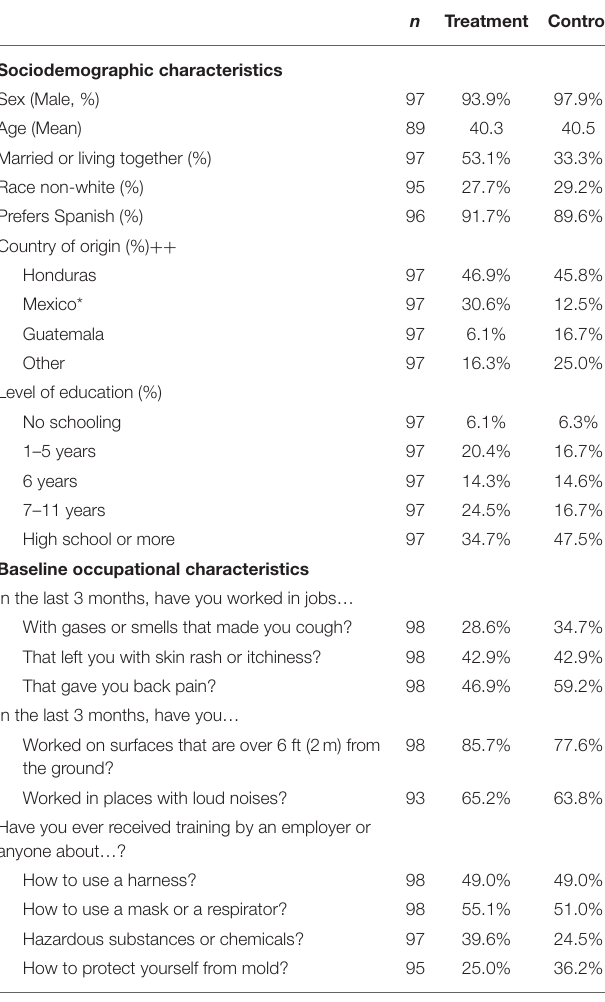
TABLE 3 | Participant characteristics by study arm.